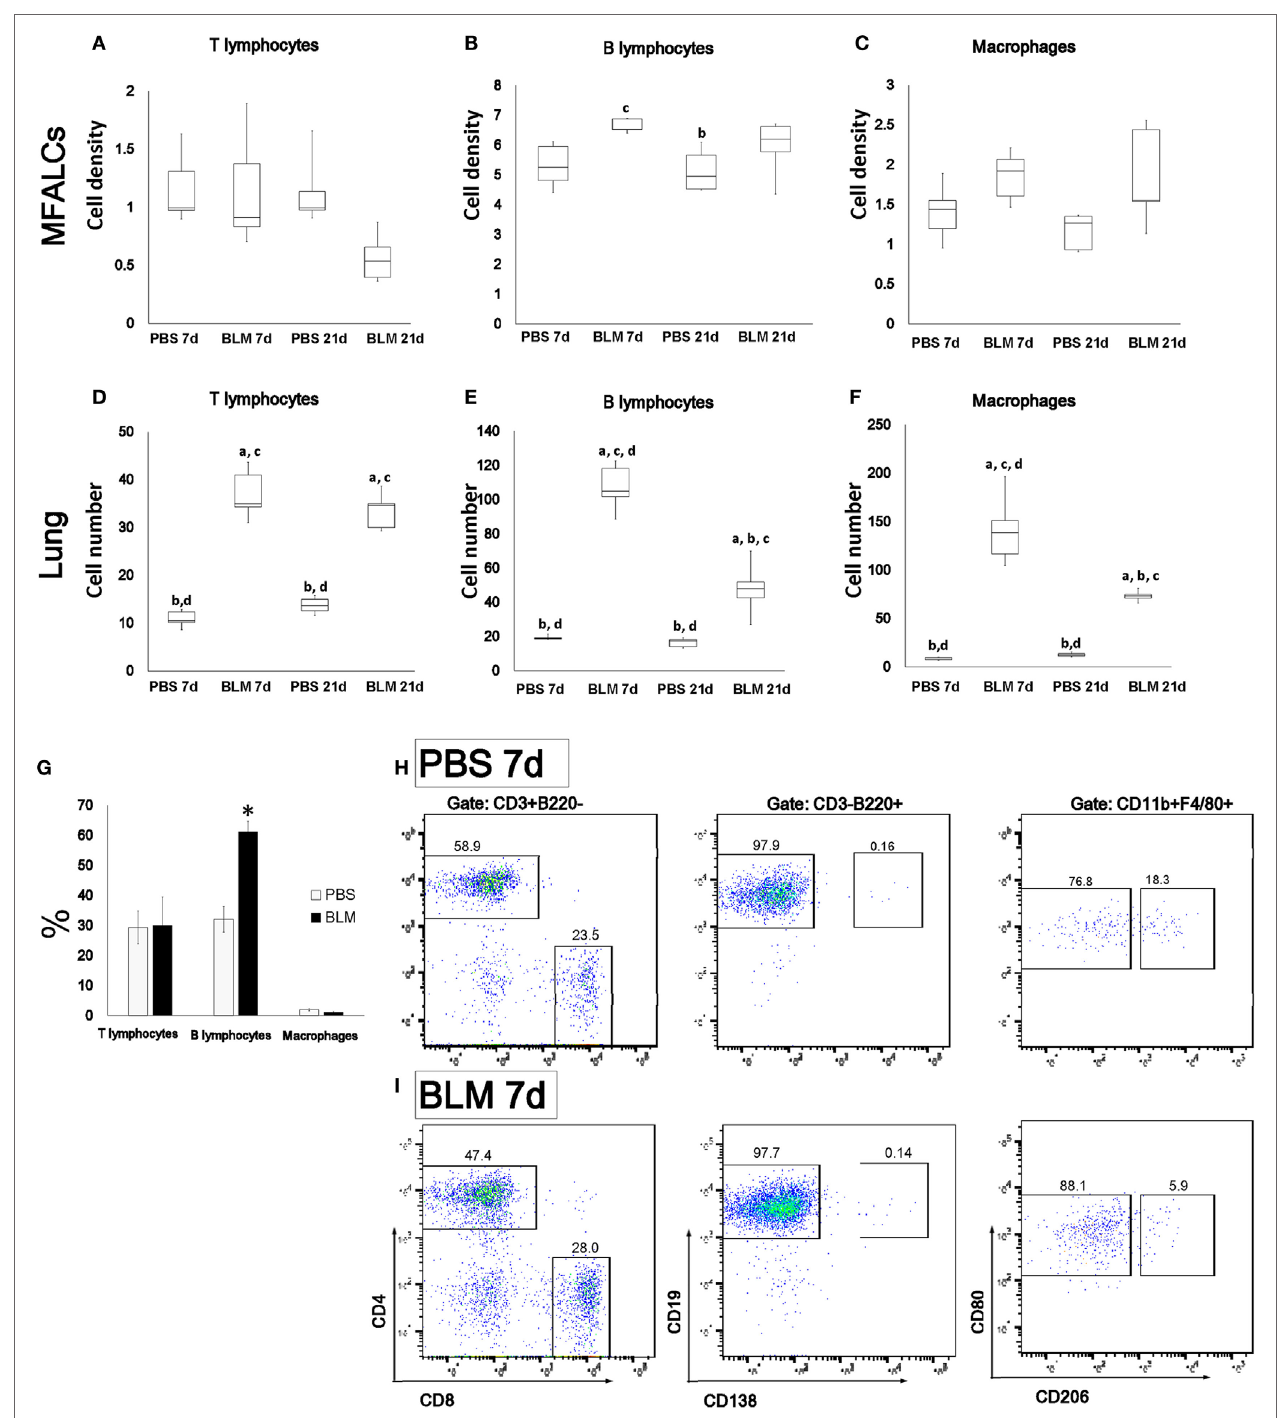
FigUre 3 | Immune cell populations in mediastinal fat-associated lymphoid clusters (MFALCs) and lungs of bleomycin (BLM)-induced pneumonitis. Densities of T-cells, B-cells, and macrophages in MFALCs (a–c) , and their average numbers in lung tissues (D–F) . The letters a, b, c, and d: significant differences between phosphate-buffered saline (PBS) group at 7 days (a), BLM group at 7 days (b), PBS group at 21 days (c), and BLM group at 21 days (d), analyzed by Kruskal–Wallis followed by Scheffé’s method ( P < 0.05); n = 5 in each experimental group. Values = mean ± SE. The % of T-cells, B-cells, and macrophages in MFALCs were detected by flow cytometry among PBS and BLM groups at 7 days (g) ( n ≥ 3 mice of each group). Statistically significant difference, as determined by the Mann–Whitney U -test (p < 0.05); comparison between the BLM and PBS groups at 7 days, with significance indicated by an asterisk (*). Values are shown as the mean ± SE. Flow cytometric analysis of T-cells (CD4/CD8), B-cells (CD19/CD138), and macrophages (M1/M2) subpopulations in MFALCs of PBS group (h) , and BLM group (i) at 7